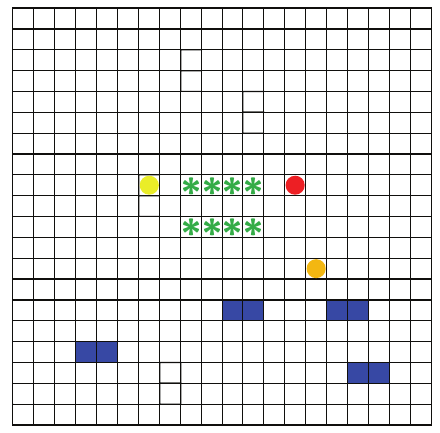
Figure 2: Push, rotate, and stop configurations: two robots can push an object along or rotate it. A stop configuration would only occur when the user is intending to stop assistant robots from completing the wrong task.